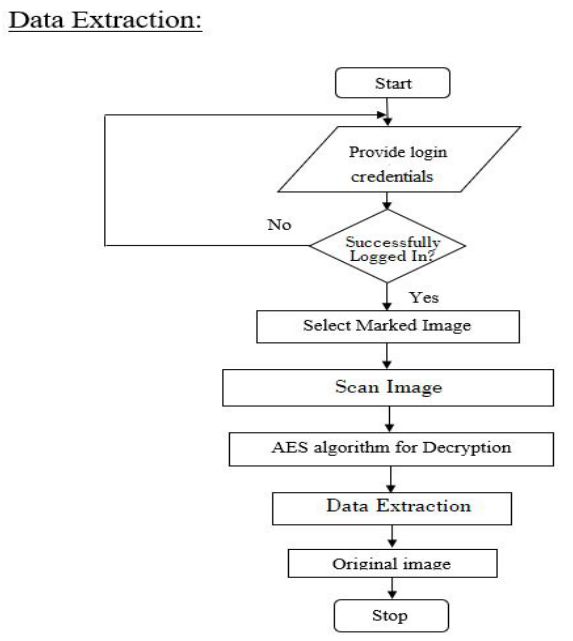
Figure 3. DECRYPTION FLOWCHART